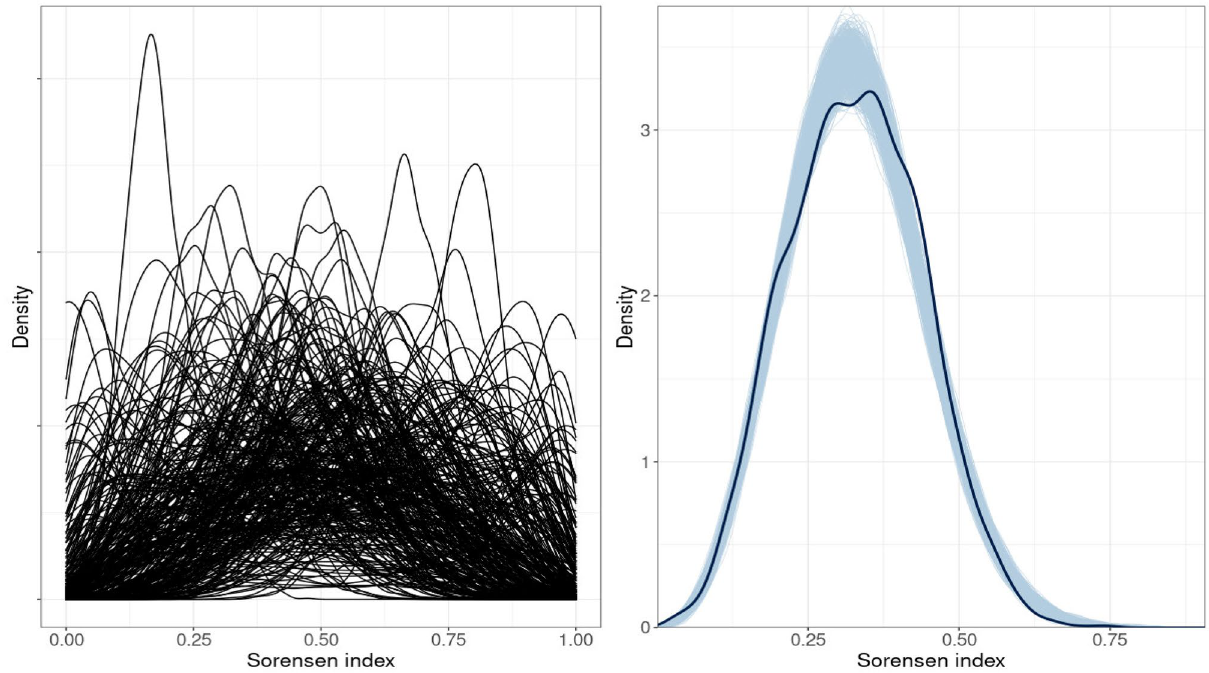
Figure 3. Density plots showing prior predictive distribution (left) and the observed. distribution of Sorensen indices (thick line) against 1000 posterior distributions (thin lines)